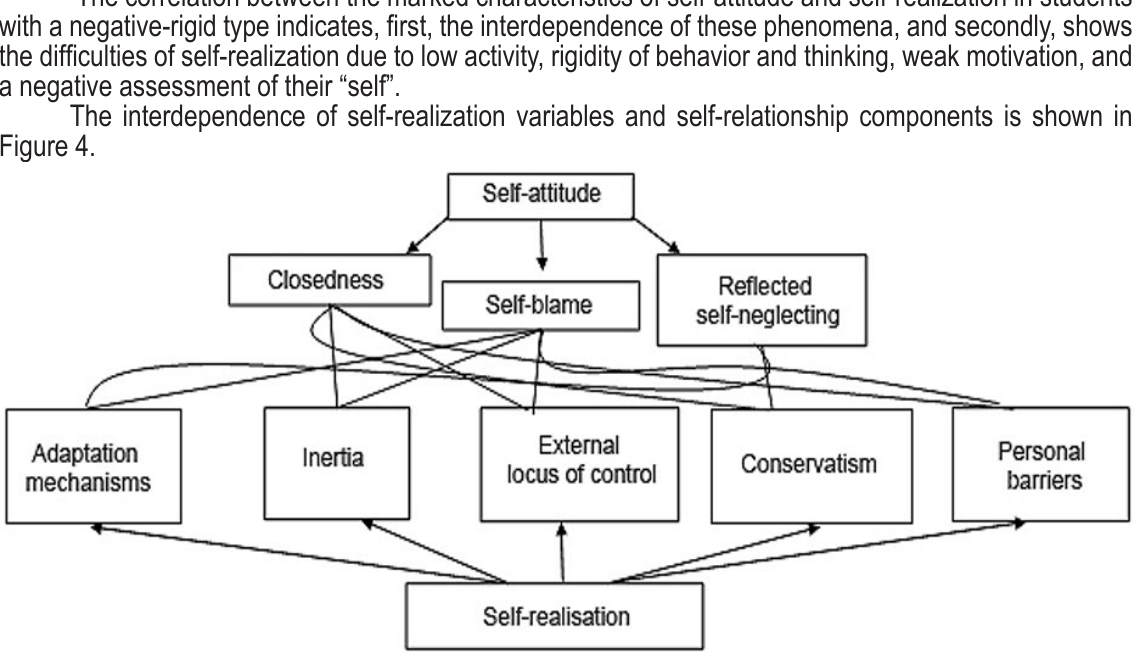
Figure 4. Correlations of components of self-attitude and self-realization in students with a socially dependent type of